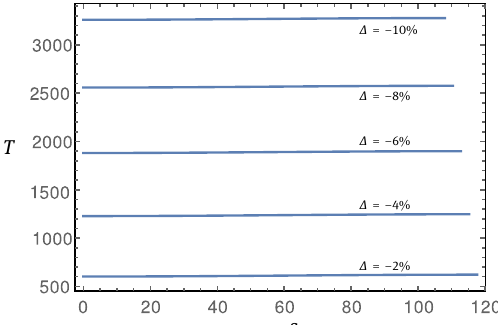
Figure 4: Taut cable: modulus of the tension T for different values of ∆ ; [ s ] = m , [ T ] = kN